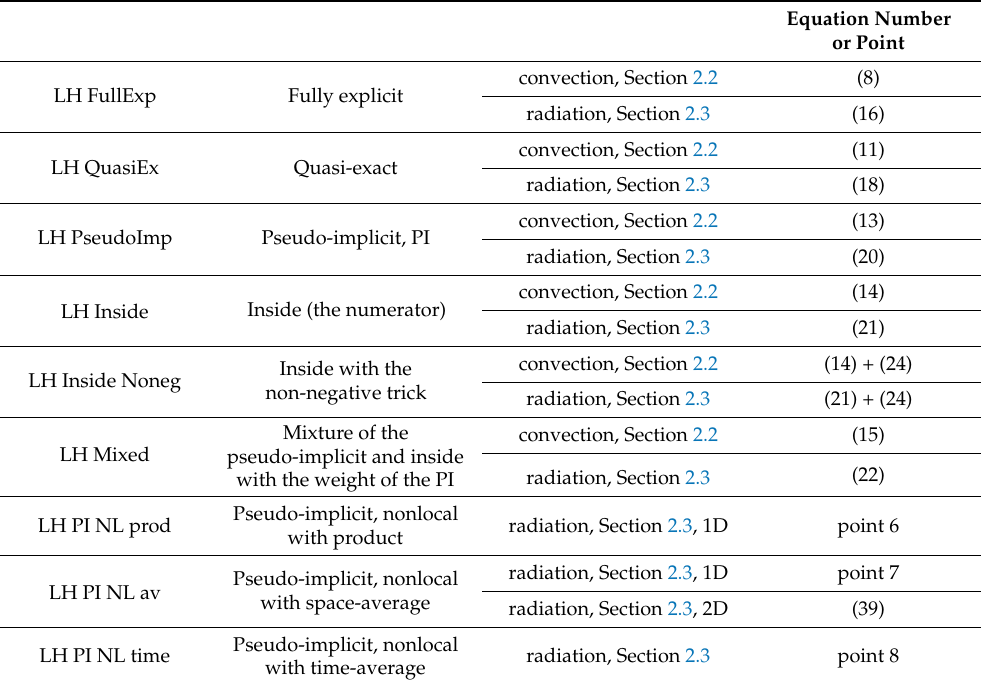
Table 1. The different treatments of the convection and the radiation terms and the defining